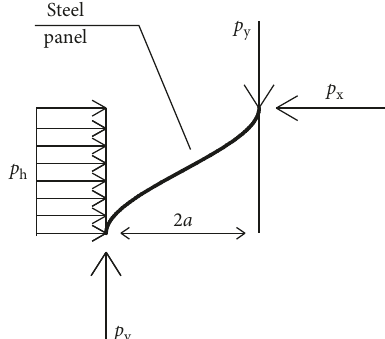
Figure 11: Balance relation of the buckling